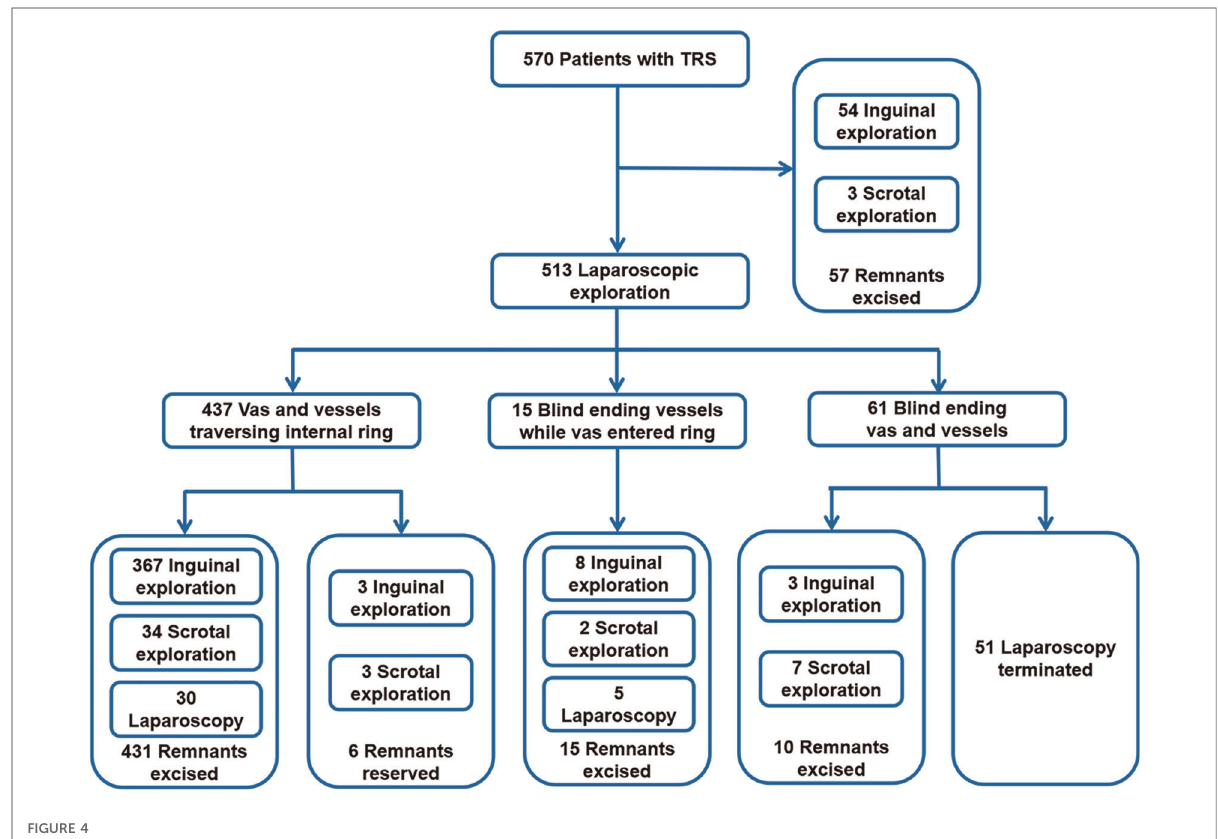
FIGURE 4 Overview of our approach and the surgical fi ndings.